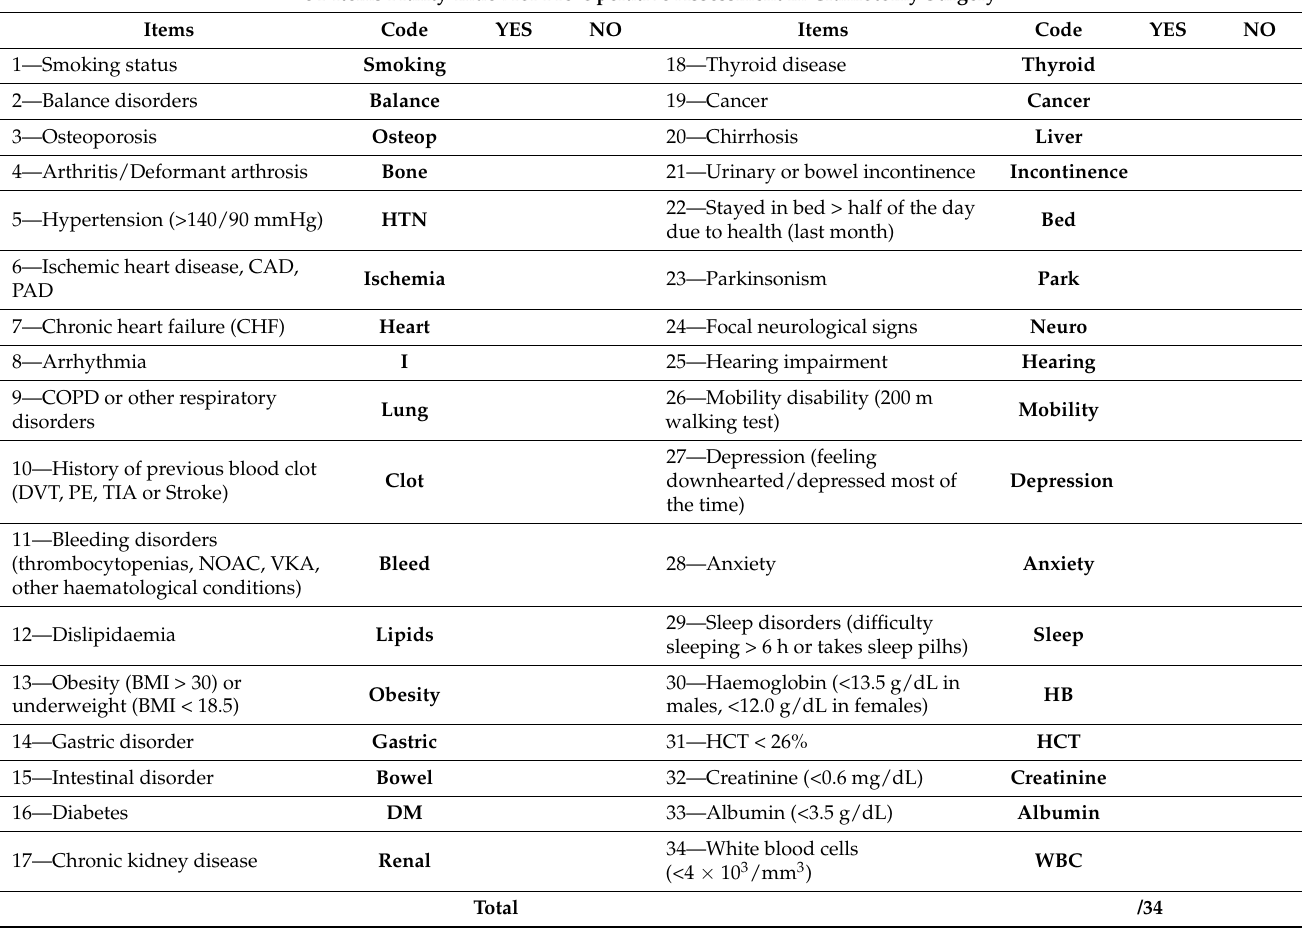
Table 1. Frailty